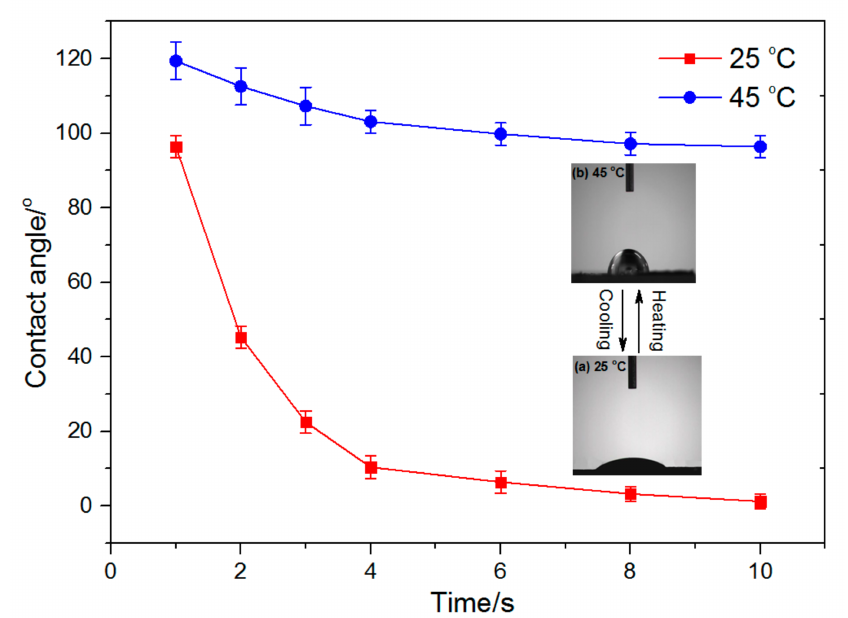
Figure 9. Time dependence of water contact angle for Nano-6 nanofibers sample at different tempera- tures (the insert images were the water droplet shape on the Nano-6 sample in 8 s at ( a ) 25 ◦ C and ( b ) 45 ◦